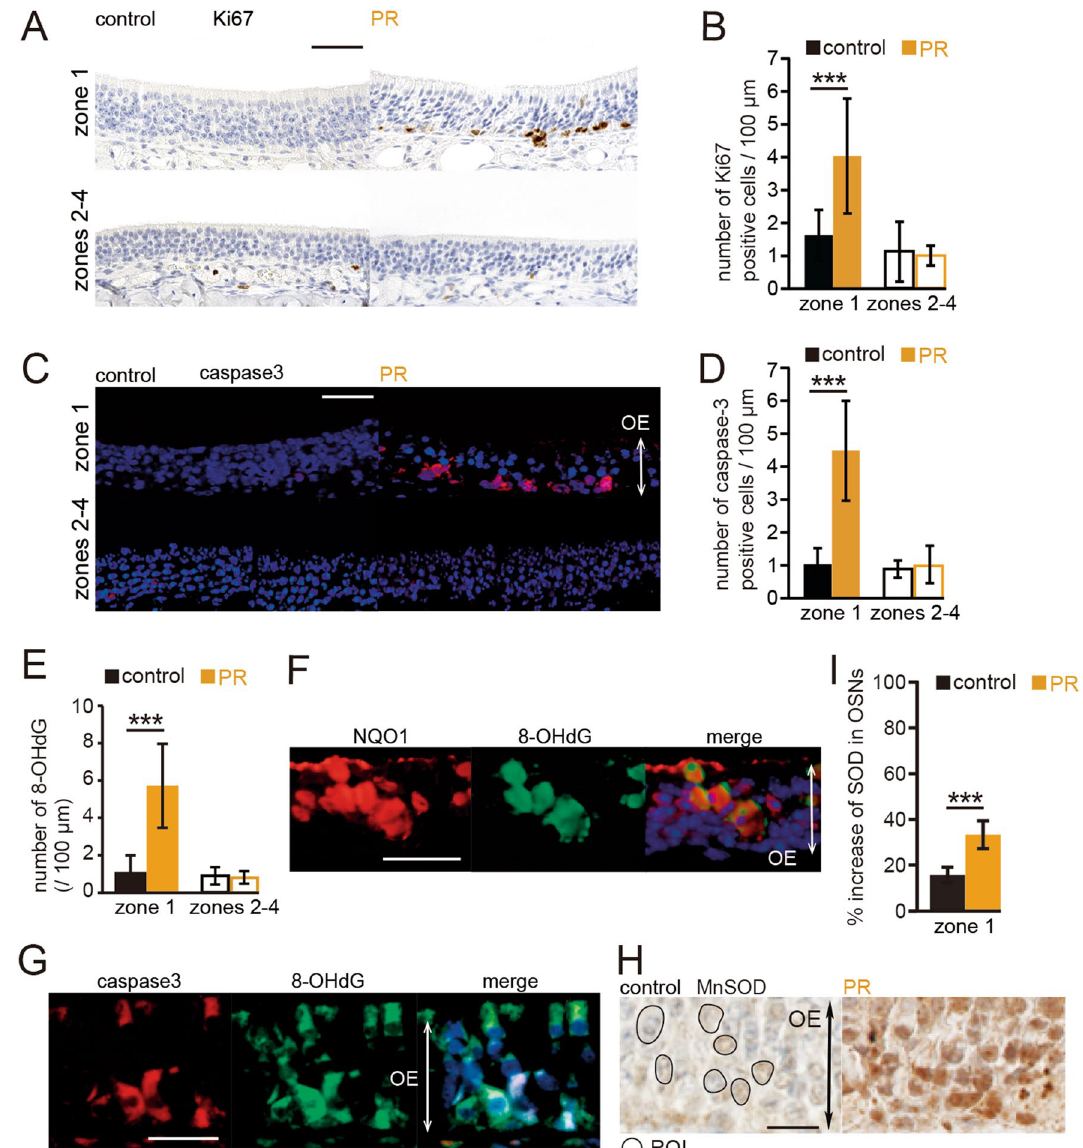
Figure 7. 8-OHdG production occurred substantially in NQO1-positive cells and could be involved in the apoptosis of OSNs in zone 1. ( A ) Representative images of Ki67-positive cells of zone 1 and zones 2–4 in control and PR mice. Scale bar 50 μm. ( B ) The number of Ki67-positive cells in zone 1 and zones 2–4 in control and PR mice. In zone 1, the number of Ki-67-positive cells in PR mice was significantly higher than that in control mice (***P < 0.001, Mann–Whitney test), whereas in zones 2–4, the number of Ki67-positive cells in PR mice was not significantly different from that in control mice. ( C ) Representative images of the c-fos-positive cells of zone 1 and zones 2–4 in control and PR mice. OE olfactory epithelium. Scale bar 50 μm. ( D ) The number of c-fos- positive cells in zone 1 and zones 2–4 in control and PR mice. In zone 1, the number of c-fos-positive cells in PR mice was significantly higher than that in control mice (***P < 0.001, Mann–Whitney test), whereas in zones 2–4, the number of c-fos-positive cells in PR mice was not significantly different to that in control mice. ( E ) The number of 8-OHdG-positive cells in zone 1 and zones 2–4 in control and PR mice. The number of 8-OHdG- positive cells in PR mice was significantly higher than that in control mice (***P < 0.001, Mann–Whitney test). ( F ) Representative images stained with anti-NQO1 antibody (red) and anti-8-OHdG antibody (green) in PR mice. Most of the 8-OHdG-positive cells were co-stained with anti-NQO1 antibody. OE olfactory epithelium. Scale bar 30 µm. ( G ) Representative images stained with anti-caspase 3 antibody (caspase3, red) and anti-8- OHdG antibody (green) in PR mice. A majority of the 8-OHdG-positive cells were co-stained with anti-caspase 3 antibody. Scale bar 30 µm. ( H ) Representative images stained with anti-MnSOD antibody in control and PR mice. In this analysis, we measured the intensity of the immunostaining in the OSNs (circle) for anti-MnSOD antibody and calculated the relative intensity of the immunostaining in the OSNs compared with axon bundles. OE, olfactory epithelium. ROI, region of interest. Scale bar, 20 µm. ( I ) Summary of the percent increases of MnSOD-immunostaining in OSNs in control and PR mice. The relative intensities of OSNs in PR mice were significantly higher than those in control mice (***P < 0.001, Mann–Whitney